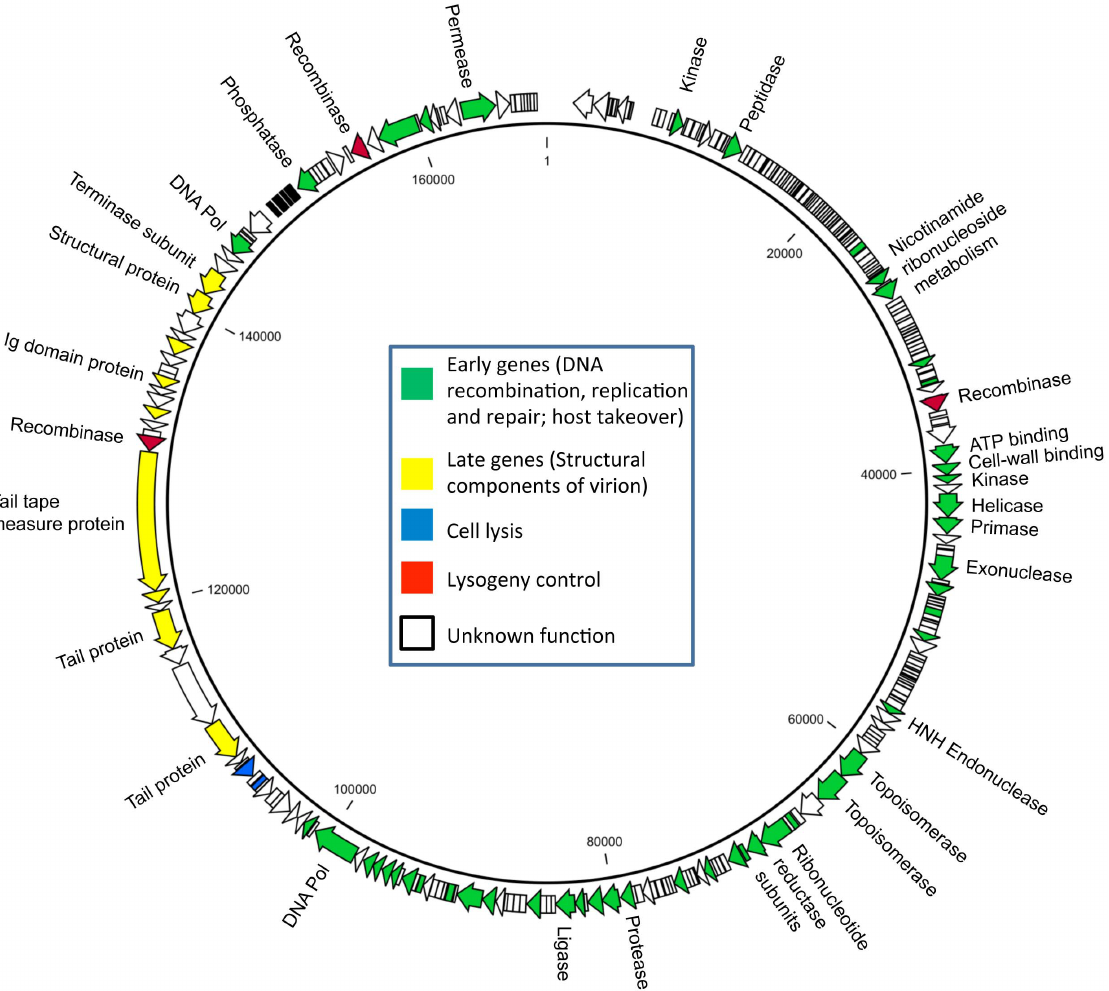
Figure 2. Genome map of Tsamsa phage. Open reading frames are drawn to scale and transcription direction is indicated by arrows. Selected proteins with putative function are labeled. Genetic modules (i.e. structural genes, early genes) are indicated by coloring.